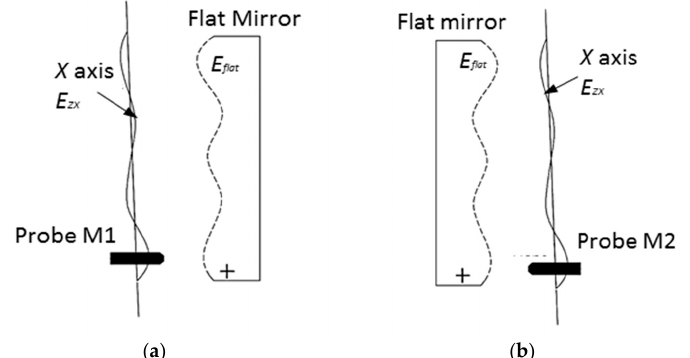
Figure 6. Schematic diagram of the E ZX measurement. ( a ) Before reversal operation, ( b ) After reversal operation.